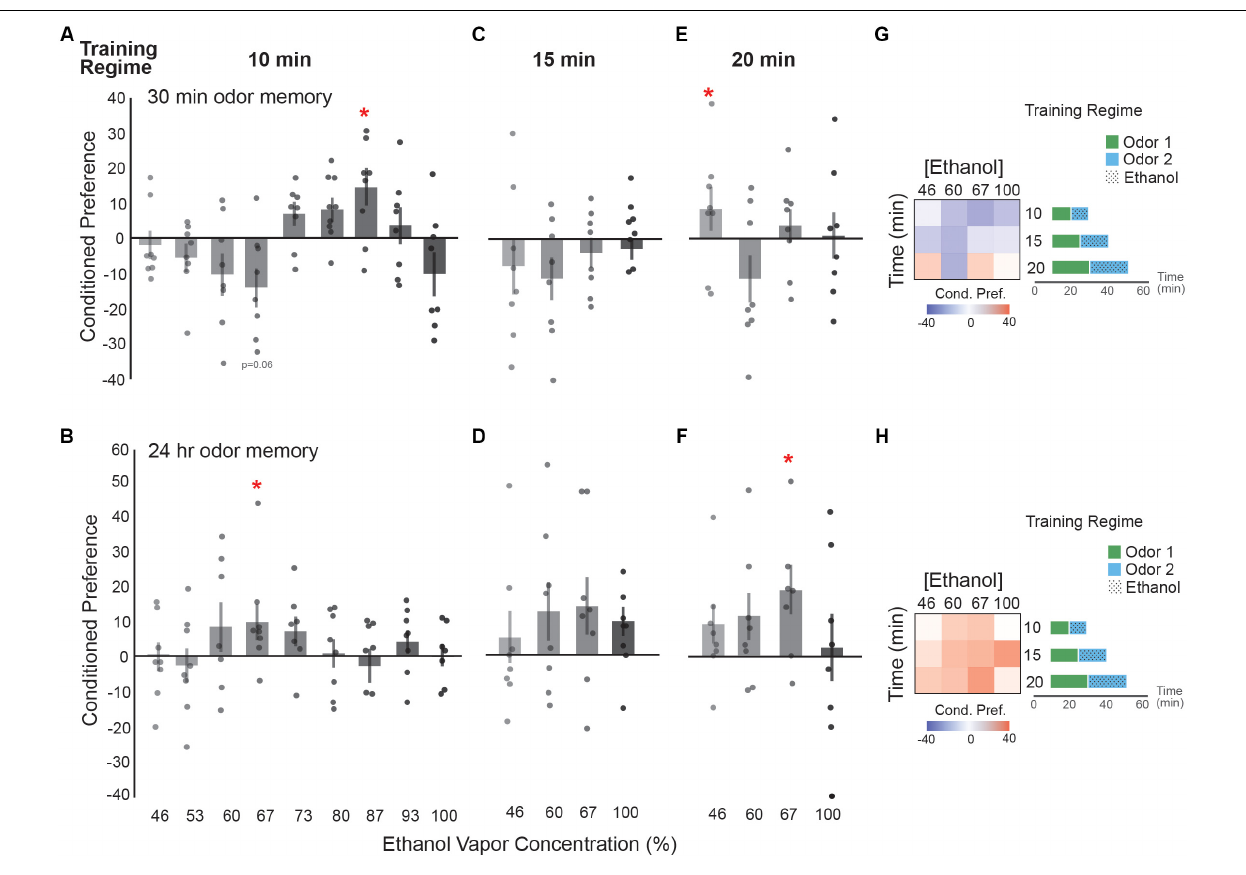
FIGURE 2 | Ethanol preference is dose-dependent. (A) Distinct groups of flies were exposed to ethanol at increasing concentrations and sacrificed prior to calculating a preference score. Flies receiving a 67% dose of ethanol vapor showed a trending aversive memory [ t (13.75) = 2.08, p = 0.06] whereas flies receiving a 87% ethanol vapor dose show a significant appetitive memory [ t (13.81) = − 2.34, p = 0.04]. (B) Flies receiving a 67% ethanol vapor dose show a significant appetitive memory [ t (14.00) = − 2.56, p = 0.02]. (C) A non-significant trend toward aversive preferences occurs at 30 min post-training when exposure duration is increased to 15 min. (D) A non-significant trend toward appetitive ethanol preference is displayed at 24 h with a 15 min exposure duration. (E) Increasing the exposure duration to 20 min results in significant appetitive memory at 30 min post-training with 46% ethanol [ t (14.00) = 2.74, p = 0.02]. (F) Exposure duration of 20 min results in a long-term appetitive ethanol preference with 67% ethanol [ t (11.96) = − 3.51, p = 0.004]. (G) Heat map summary of 30 min ethanol preference across different exposure durations suggesting that single 10 and 15 min exposure trainings trend toward an aversive (blue) response to ethanol at 30 min post-training. Schematics of single exposure training paradigm are depicted. (H) Heat map summary suggests a trend towards appetitive (red) ethanol preference at 24 h. Bars represent mean +/ − standard error. N ∼ 8 per group where individual data points represent N = 1 ( ∼ 100 flies) CPI. ∗ p <